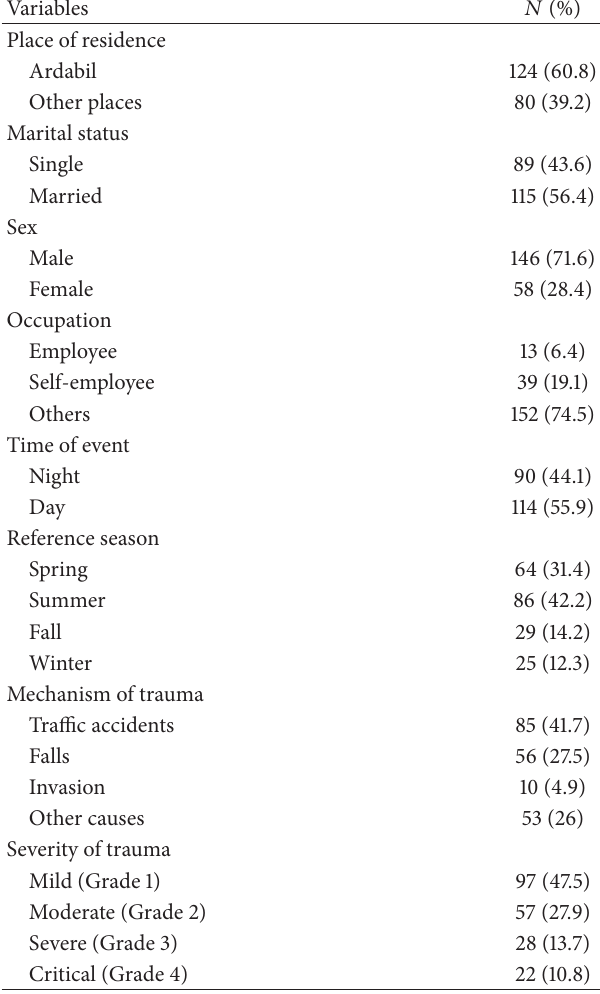
Table 1: Demographic and basic variables of the patients in